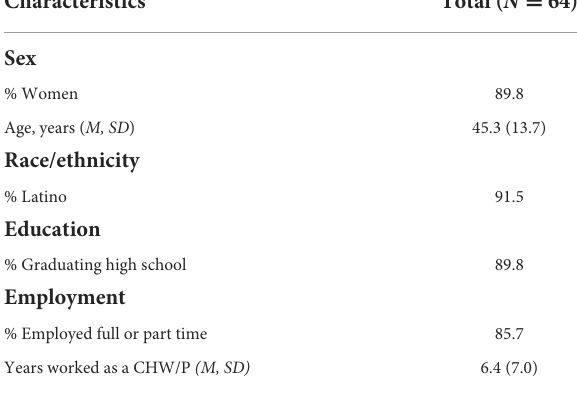
TABLE 1 Demographic characteristics of community health workers and Promotor/as .